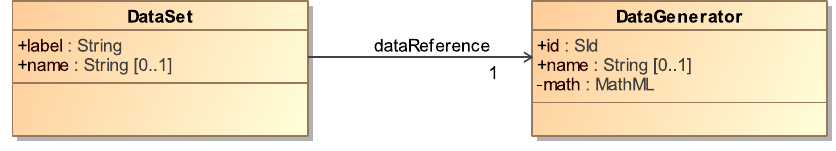
Figure 2.45: The SED-ML DataSet class